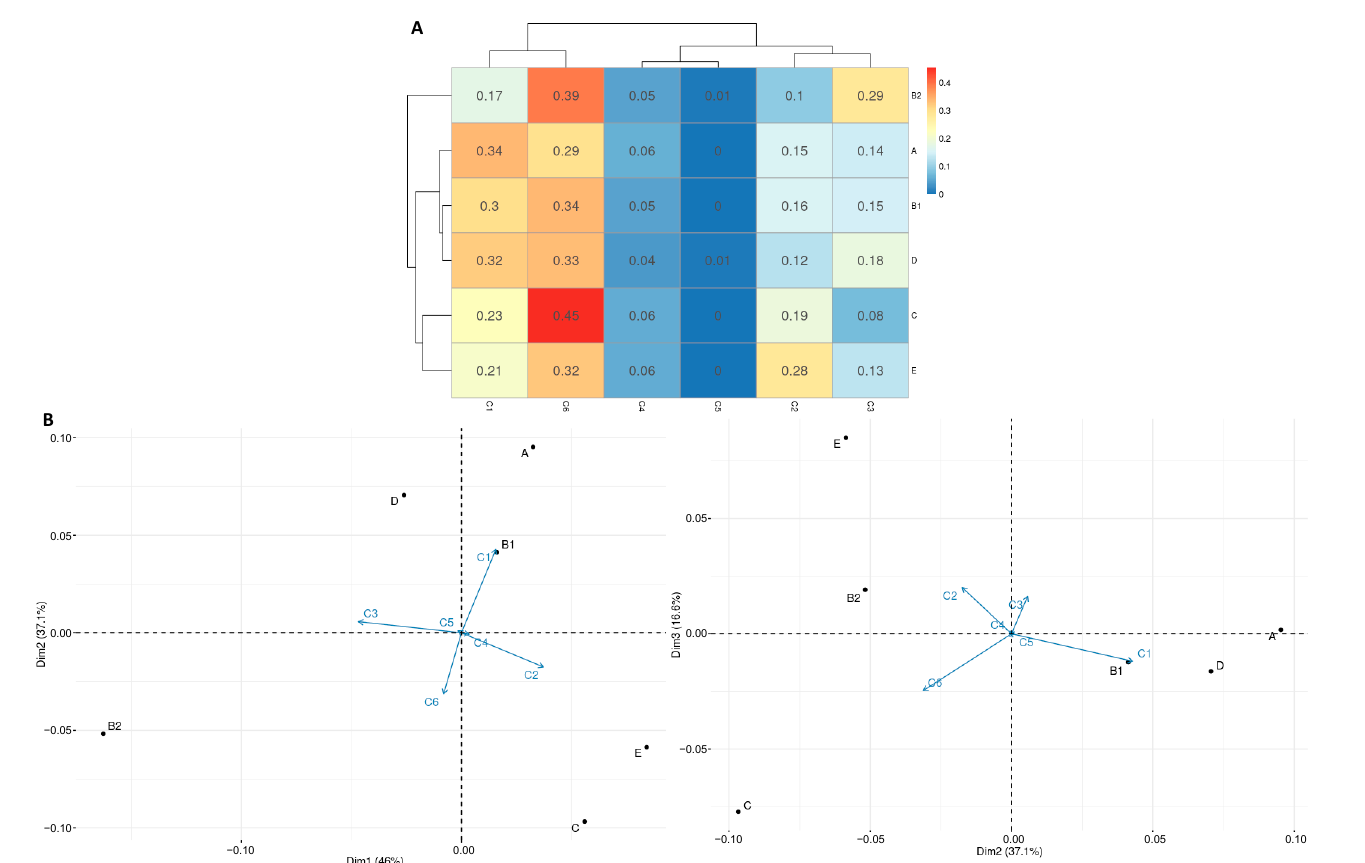
Figure 12. Statistical analyses of the relationships between the Escherichia phylogroups respective to the different Ag43 classes. ( A ) Heatmap indicating the ratio of the number of genomes per phylogroup and per Ag43 class. The dendrogram was calculated using an Euclidean distance matrix. Only phylogroups for which the absence of independence was statistically evidenced by pairwise independence Fisher tests ( p -value < 0.05) were taken into account ( Escherichia phylogroups F, G, cladeI, cladeV, E. albertii , and E. fergusonii were thus excluded, p -value > 0.05). ( B ) Plot of PCA based on the ratio of the number of genomes per phylogroup and Ag43 class over three dimensions. De- tailed statistical analyses are available in supplementary Table S1.